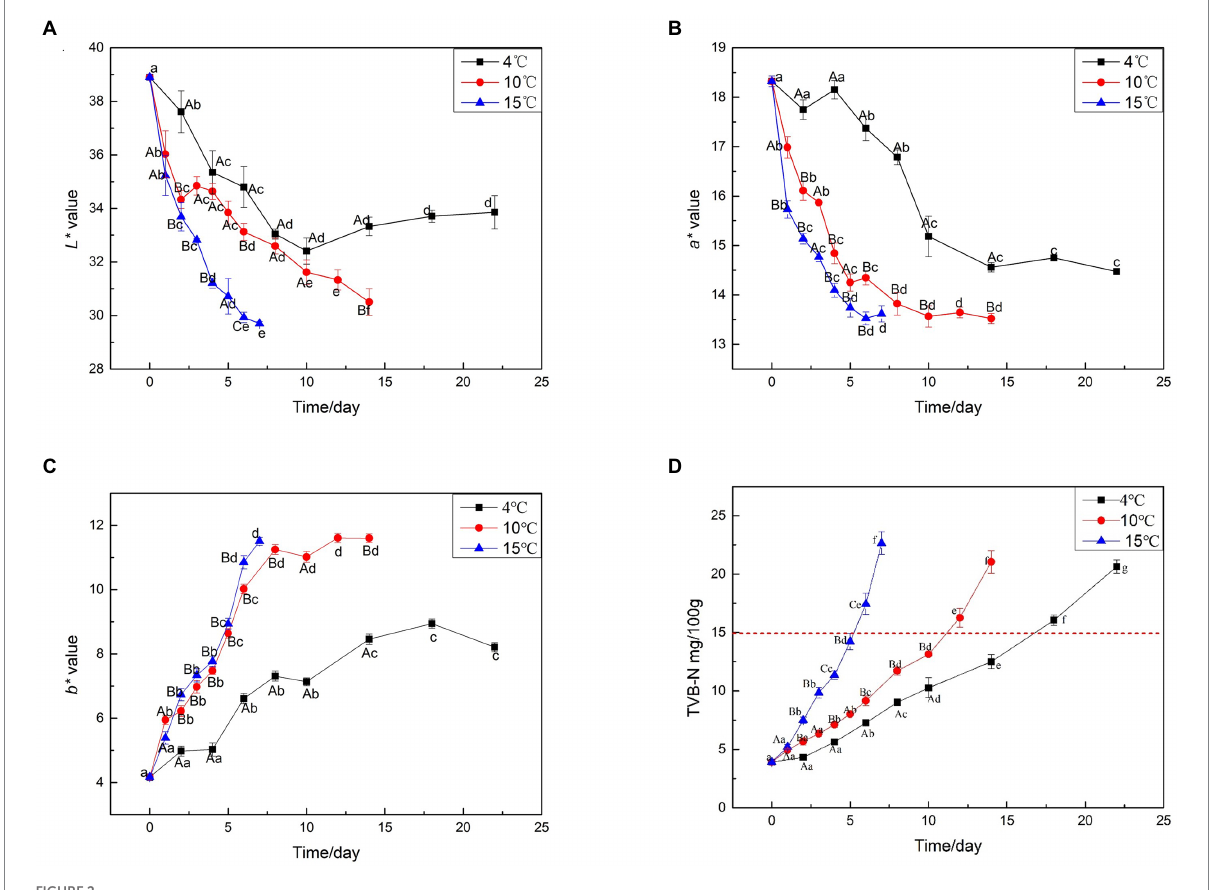
FIGURE 2 Surface color and TVB-N analysis on beef samples aging at 4, 10, and 15°C. (A) L* value, (B) a* value, (C) b* value, (D) TVB-N